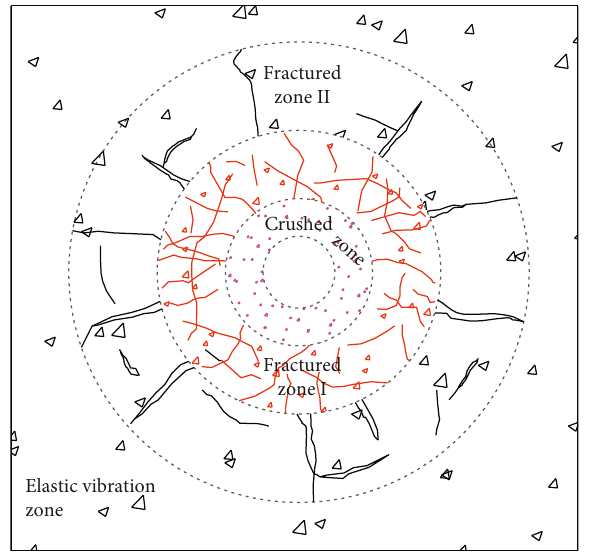
Figure 1: Partitions of rock blasting around a borehole. The combination of the crushed zone and fractured zone I is called the failure